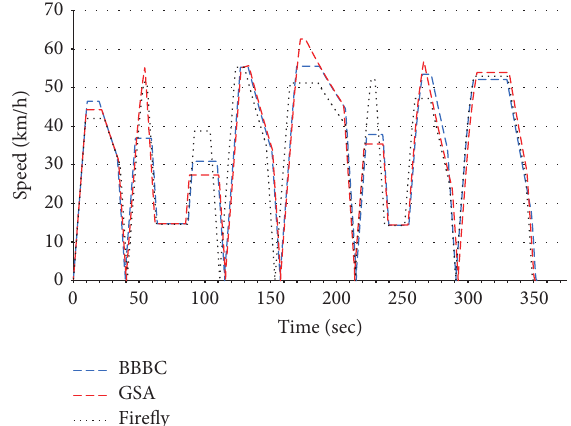
Figure 6: Speed-time graph for all algorithms (no passenger).